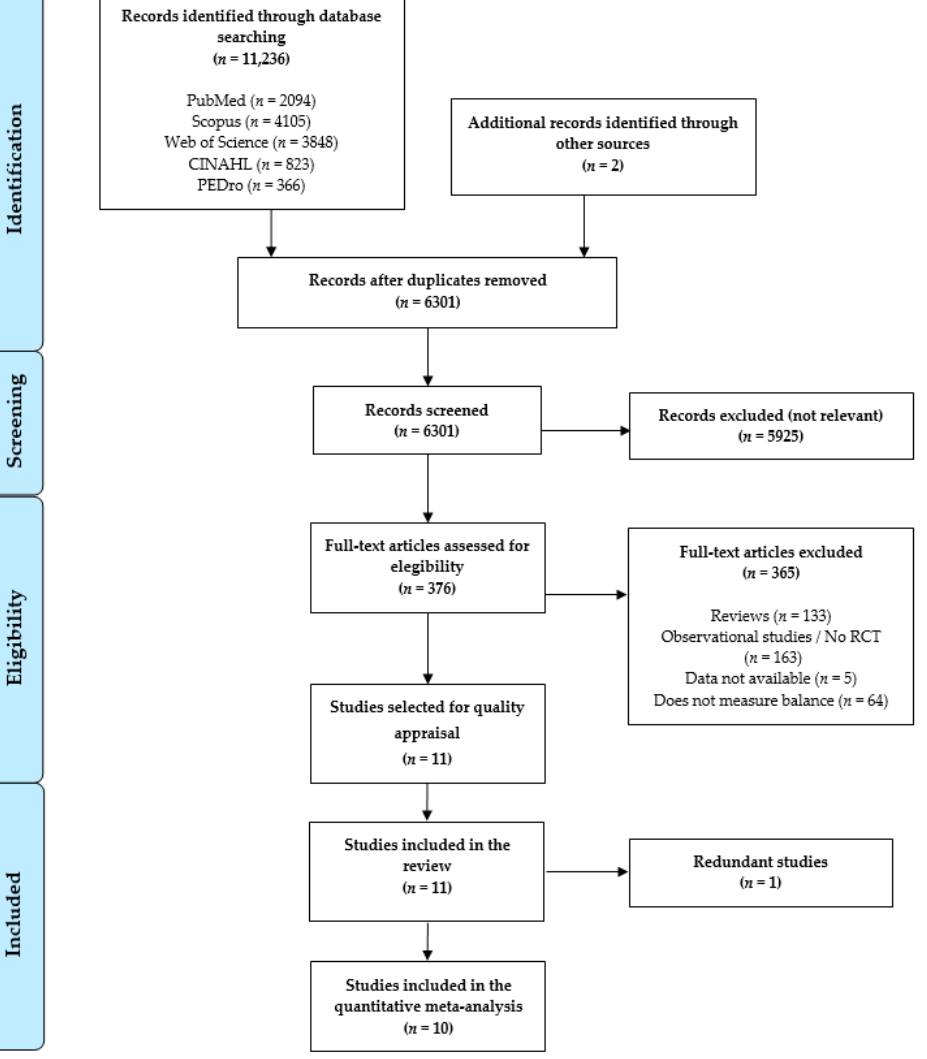
Figure 1. Preferred Reporting Items for Systematic Reviews and Meta-Analysis (PRISMA) flow chart .